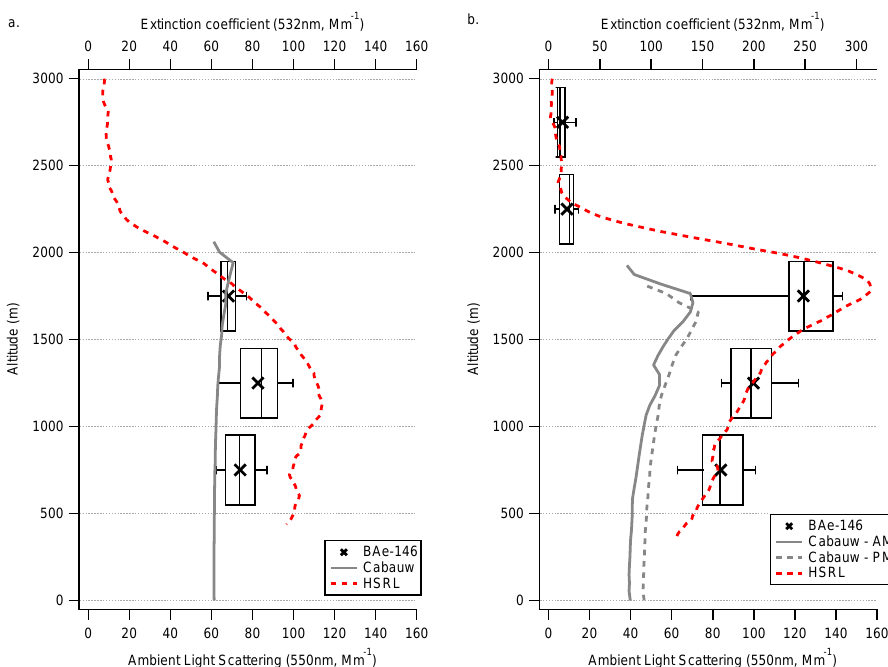
Fig. 9. Boxplot summary statistics for the measured ambient scattering profile from the BAe-146 in the vicinity of Cabauw for (a) B366 and (b) B379. Crosses represent the mean value, while horizontal lines represent the 25th, 50th and 75th percentiles. The whiskers represent the 5th and 95th percentiles. Also shown is the measured ambient scattering from the ground site at Cabauw, which is extrapolated to derive an estimated scattering profile based upon the method described in Sect. 5.1. In (a) the extinction profile from the HSRL onboard the DLR Falcon is also shown from 14:44–14:56 UTC. In (b) the extinction profile from the HSRL is shown for 13:46–13:54 UTC. Note that the scale for the nephelometer measurements and the HSRL are different in